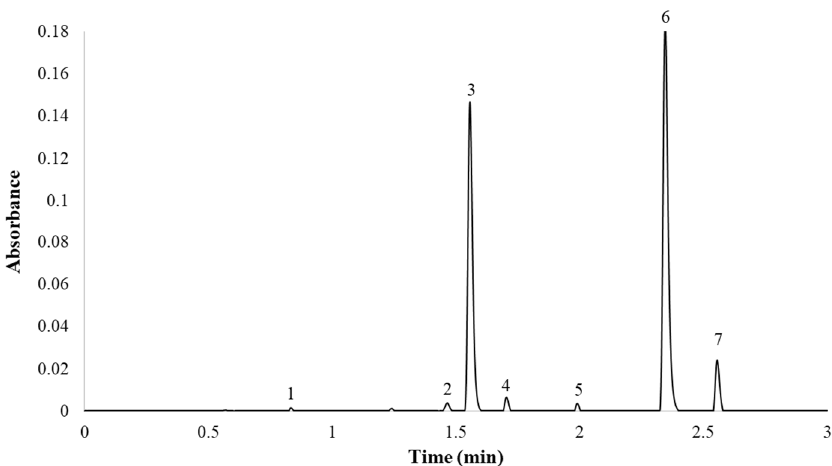
Figure 4. Red onion chromatogram at 360 nm. (1) Quercetin 3,7,4 ′ - O -triglucoside; (2) quercetin 7,4 ′ - O -diglucoside; (3) quercetin 3,4 ′ - O -diglucoside; (4) isorhamnetin 3,4 ′ - O -diglucoside; (5) quercetin 3- O -glucoside; (6) quercetin 4 ′ - O -glucoside; (7) isorhamnetin 4 ′ - O -glucoside.